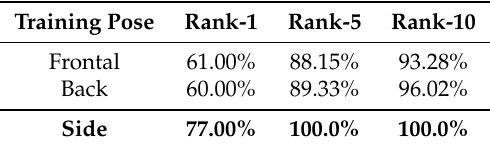
Table 5. SOMAset accuracy at different ranks under pose variation as achieved by the Inception V3 network.